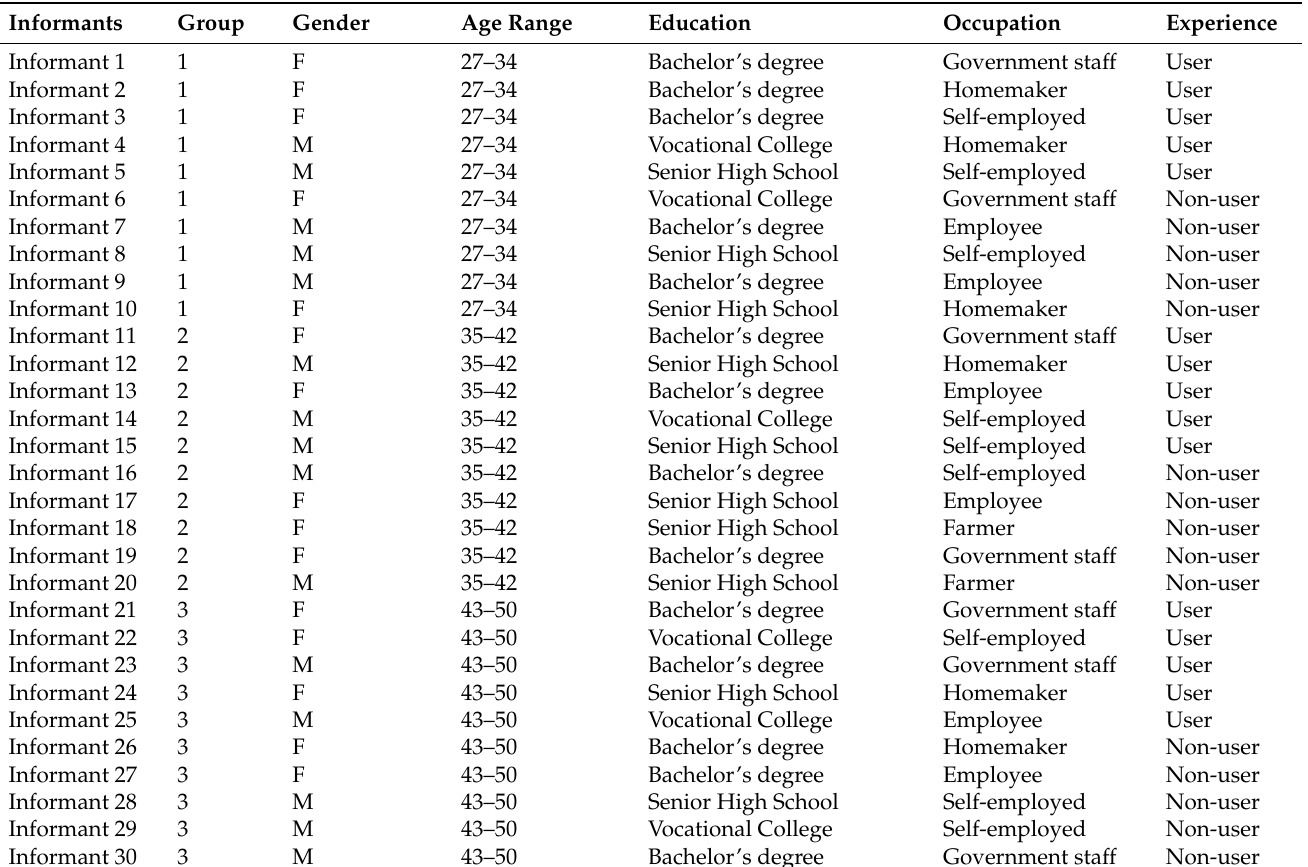
Table A1. The Total Number of Informants Located in Khon Kaen Province Per